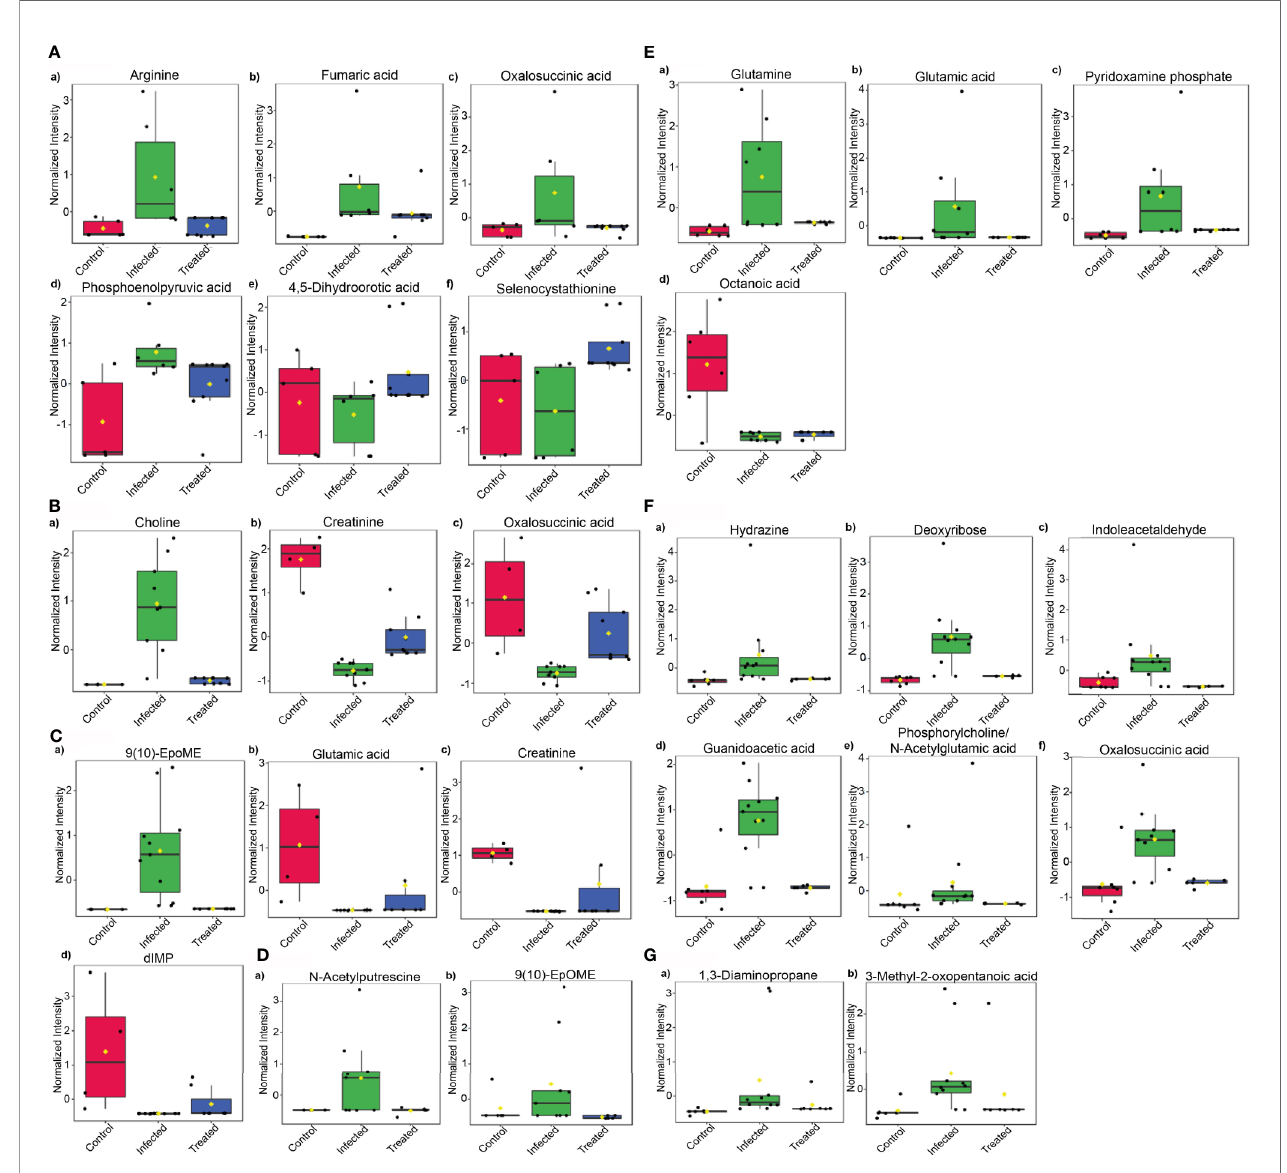
FIGURE 7 | Potential biomarkers. Pattern search using the prede fi ned pattern 1-2-1 (control-infected-treated) based on Spearman rank correlation was used to identify potential biomarkers in tissues — (A) Brain, (B) Liver, (C) Spleen, (D) Bone marrow and bio fl uids — (E) Serum, (F) Urine, and (G) Feces on the basis of their normalized